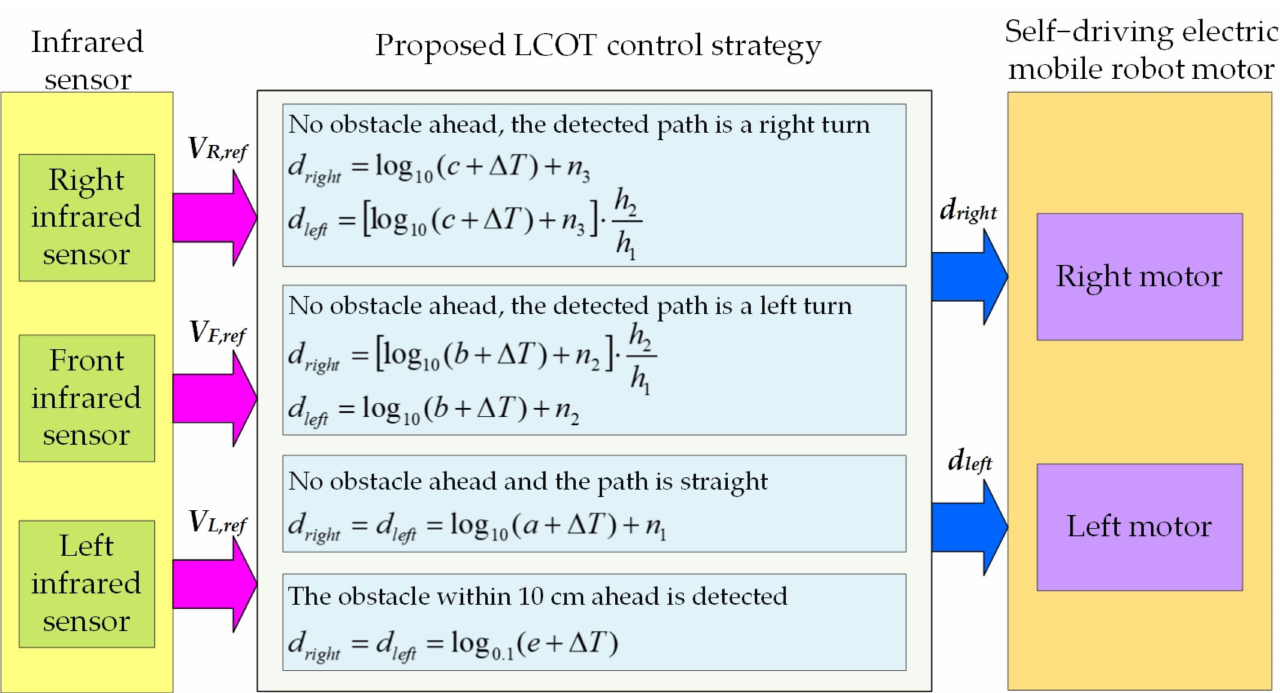
Figure 8. Architecture diagram of the self-driving electric mobile robot control